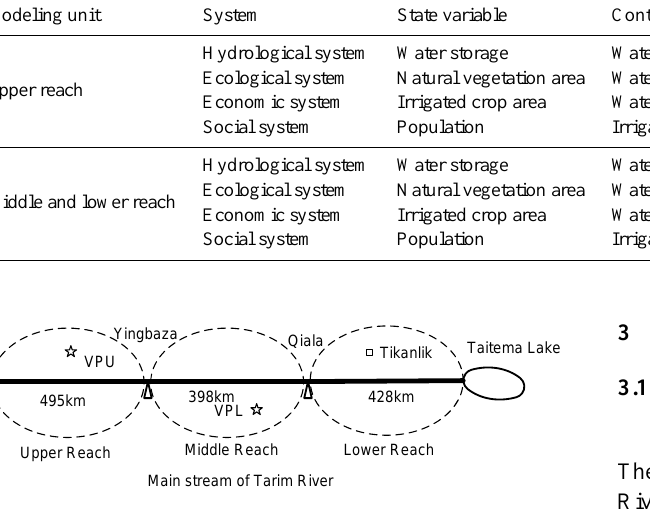
Figure 2. Sketch map of the main stream of the Tarim